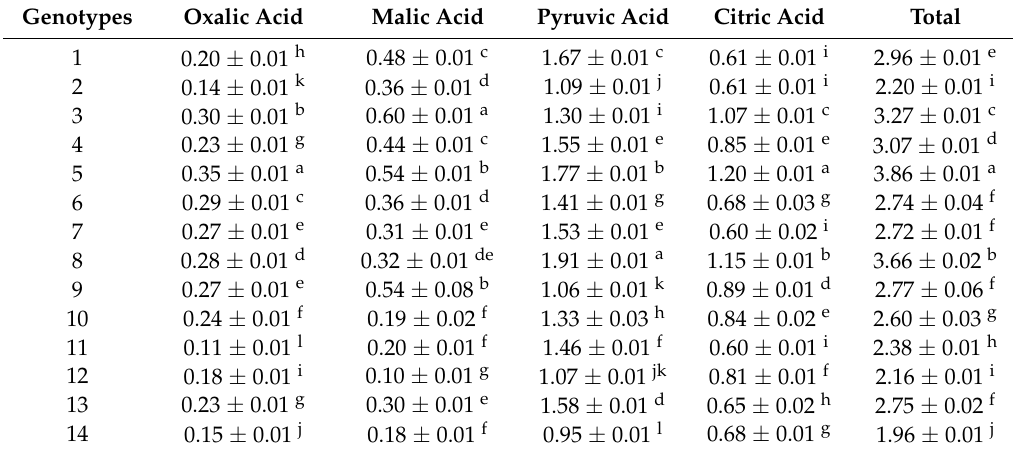
Table 4. Organic acids of the studied garlic genotypes (g/100 g f.w.; mean ± SD; n = 3). Genotypes Oxalic